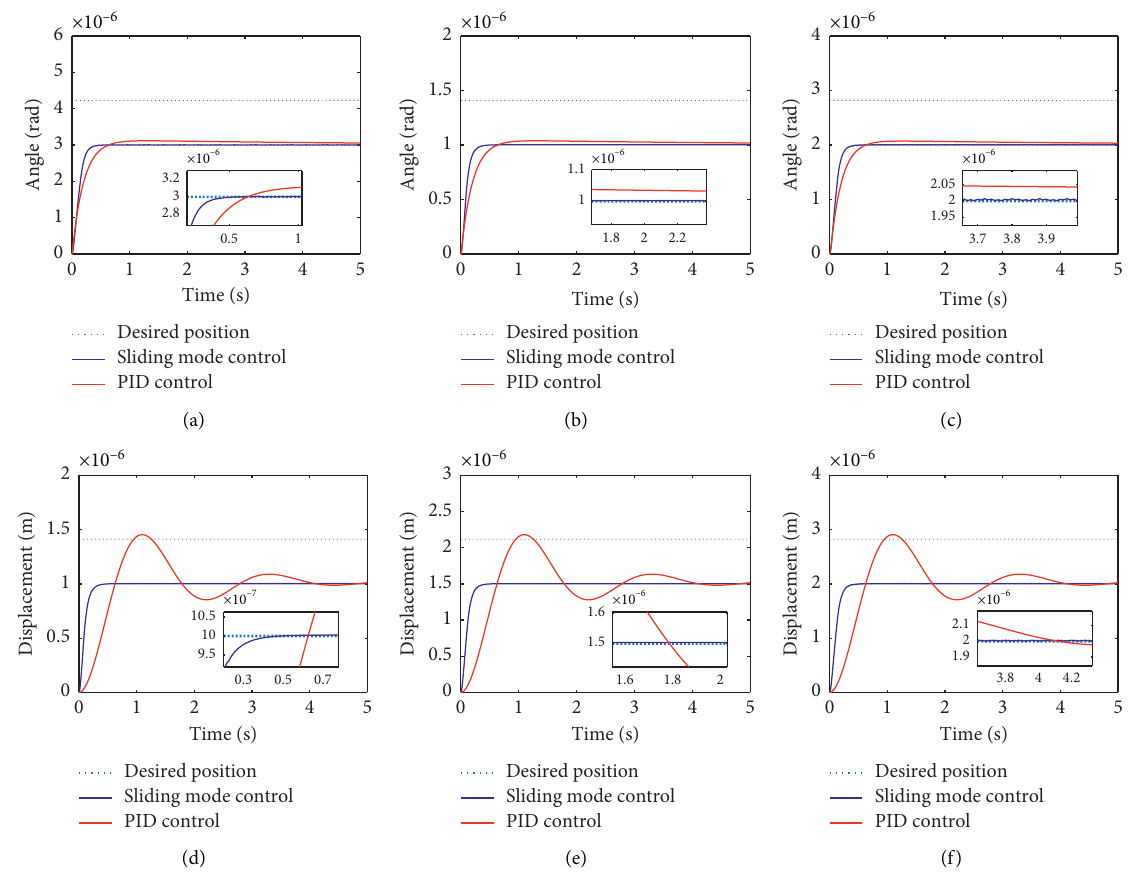
Figure 7: Tiny displacement (micron level) positioning test: (a) θ